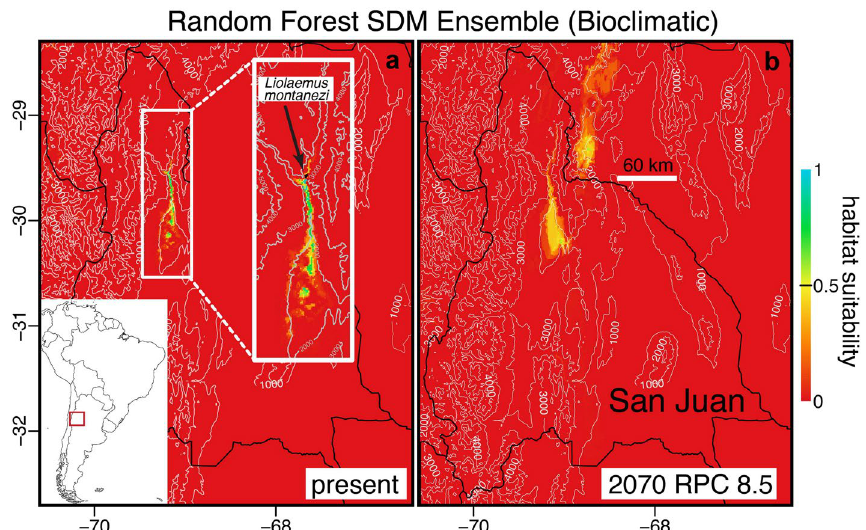
Figure 5. Suitable habitat projections for L. montanezi under bioclimatic layers and random forest algorithm (RF) at present (panel a) and 2070 RCP 8.5 (panel b). The inlay (white square) represents a close-up of the known distribution of the species. Elevation curves are also shown. These maps were generated in the R environment (R Core Team 109 ver. 3.6.1, URL: http:// www.r- proje ct. org/ index. html) using the R-packages: biomod2 ver. 3.4.6 (Thuiller et al. 110 , URL: https:// CRAN.R- proje ct. org/ packa ge= biomo d2), dismo v1.1-4 (Hijmans et al. 111 , URL: https:// CRAN.R- proje ct. org/ packa ge= dismo), and raster v3.3-13 (Hijmans 112 , URL: https:// CRAN.R- proje ct. org/ packa ge= raster) by J.C. Santos.